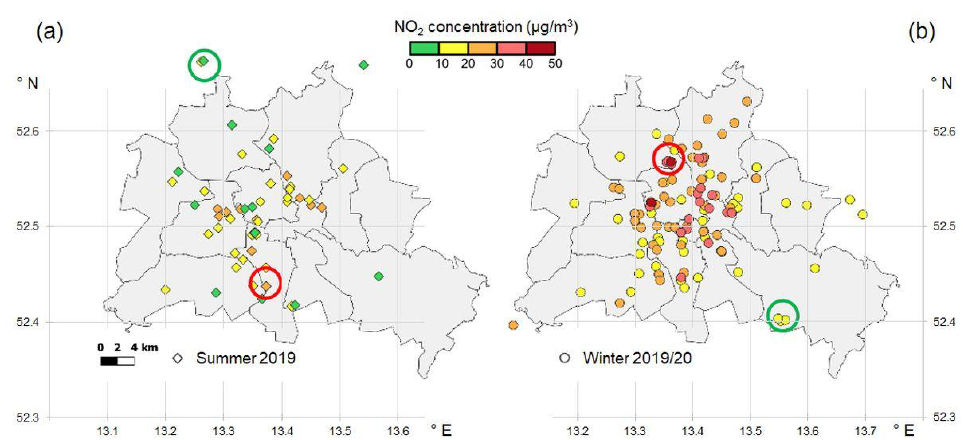
Figure 2. Spatial distribution of NO 2 concentrations in Berlin ( a ) in summer 2019 and ( b ) in winter 2019/2020. Circles indicate minimum (green circles) and maximum (red circles) NO 2 concentrations during sampling periods.